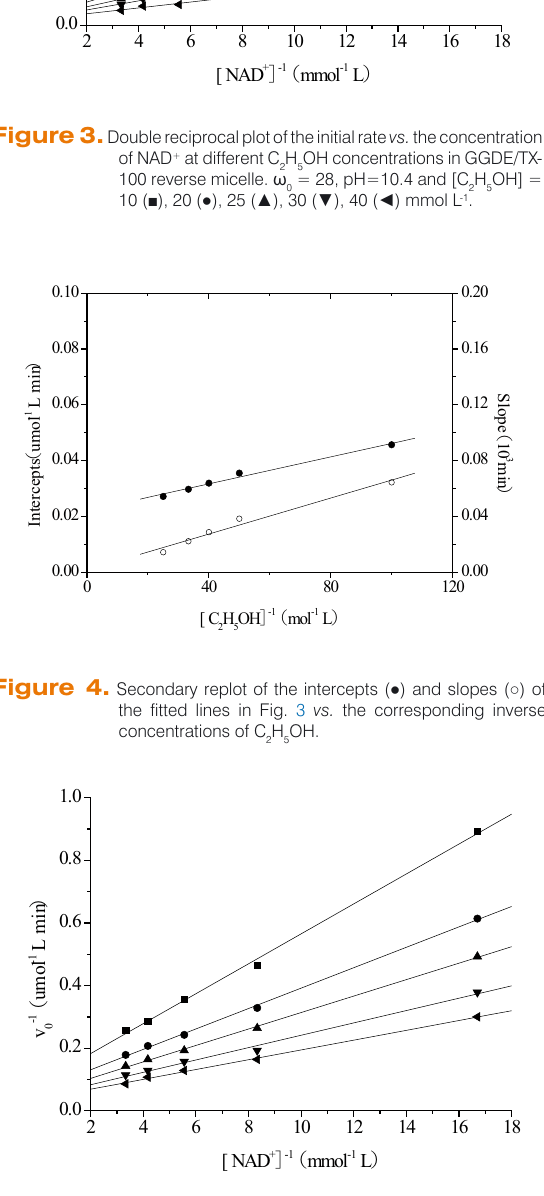
Figure 6. Secondary replot of the intercepts ( ● ) and slopes ( ○ ) of the fitted lines in Fig. 5 vs. the corresponding inverse H OH] = concentrations of C 2 5